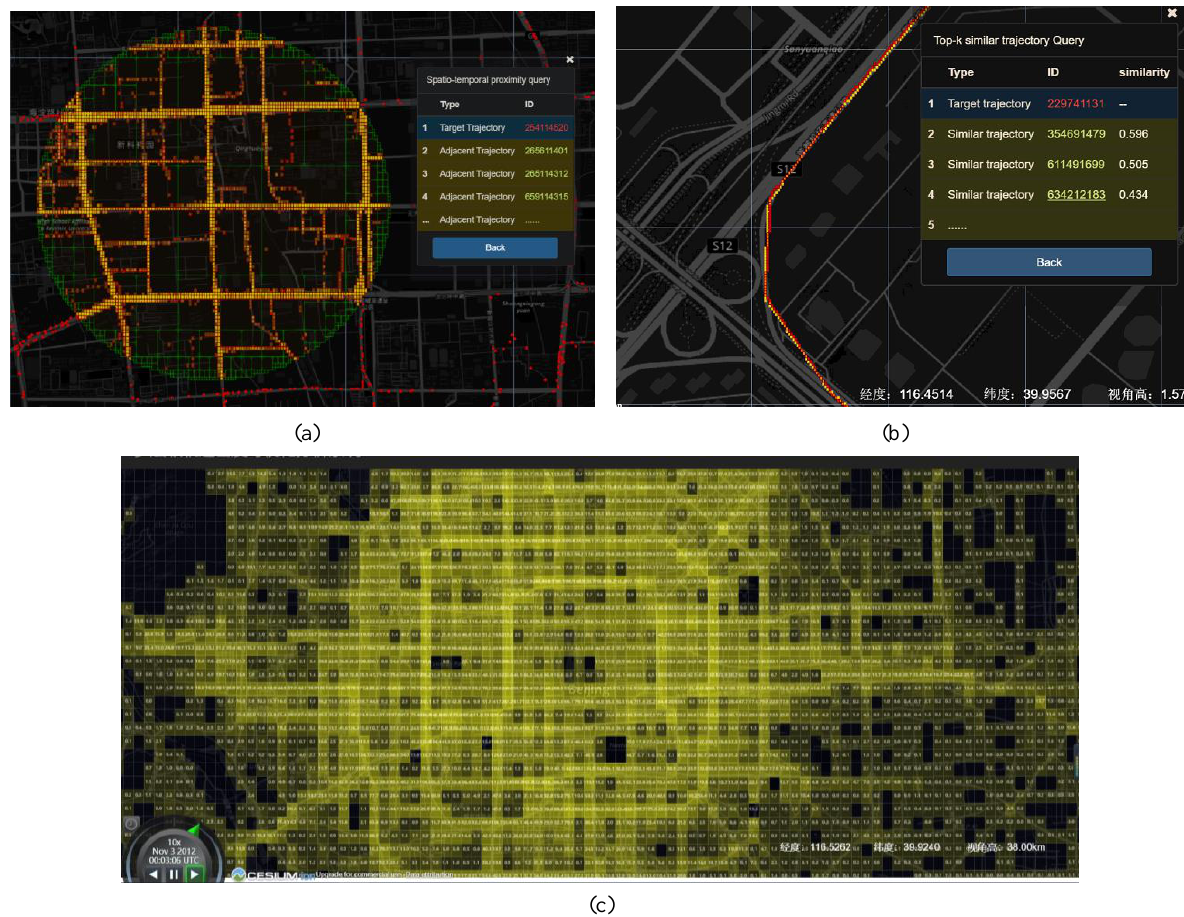
Figure 4. Examples of trajectory analysis tools in the system, (a) Spatiotemporal proximity query of trajectory, (b) Top-k similar trajectory query, (c) Fast calculation of multi-scale trajectory